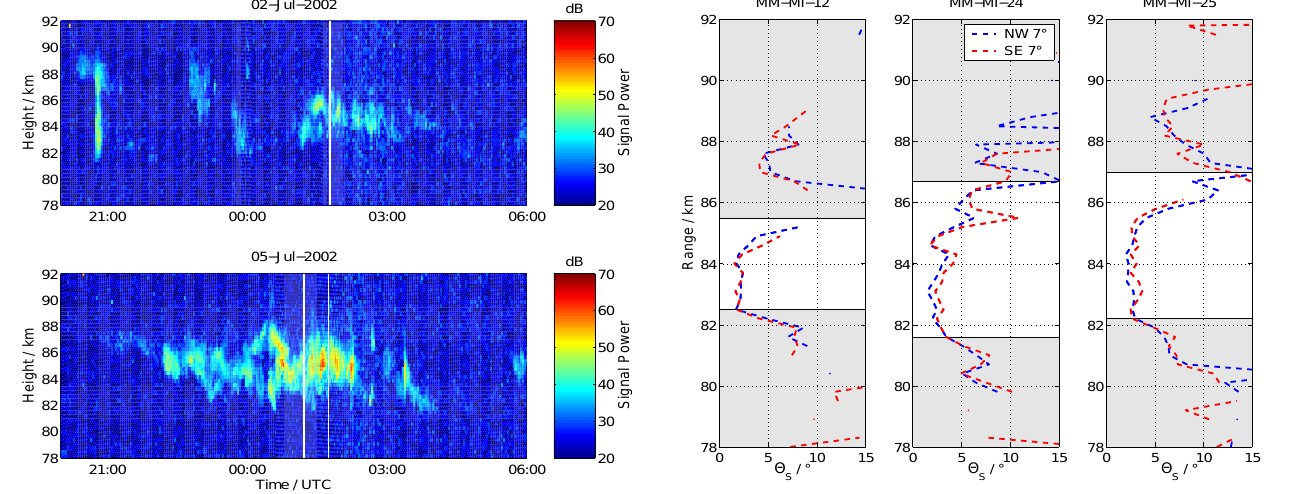
Fig. 2. Signal power for the same time interval as in Fig. 1 for the north-westward pointing beam. This is the direction of the trajec- tory of the sounding rockets during the MIDAS/MaCWAVE cam- paign.